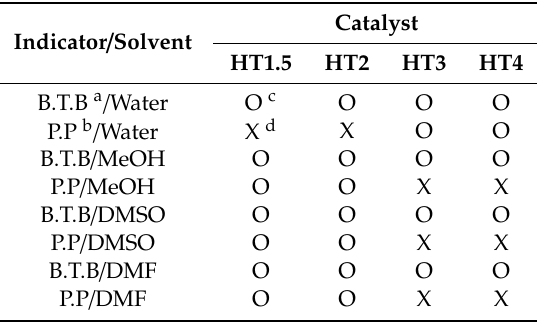
Table 3. Results of Hammett indicator experiments conducted in various